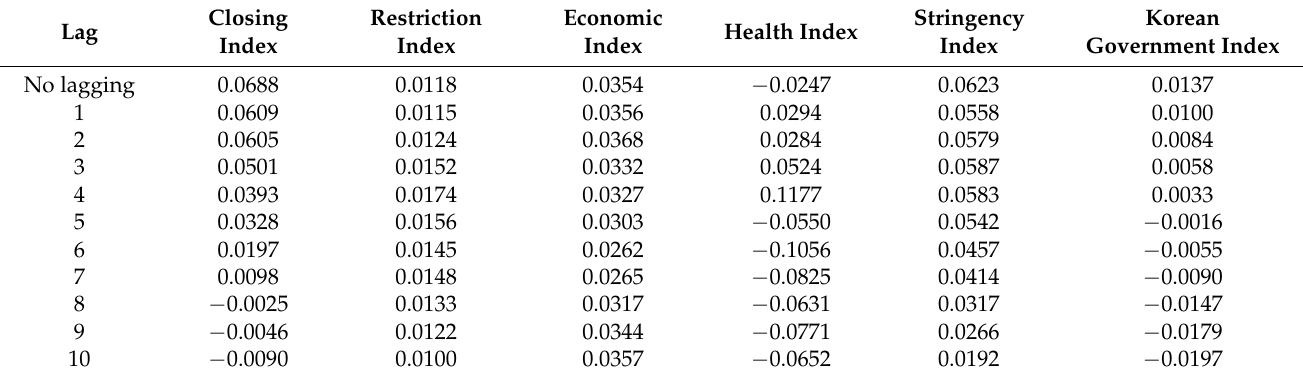
Table 3. Seoul Metropolitan Area’s Coefficients from Single Index Model.